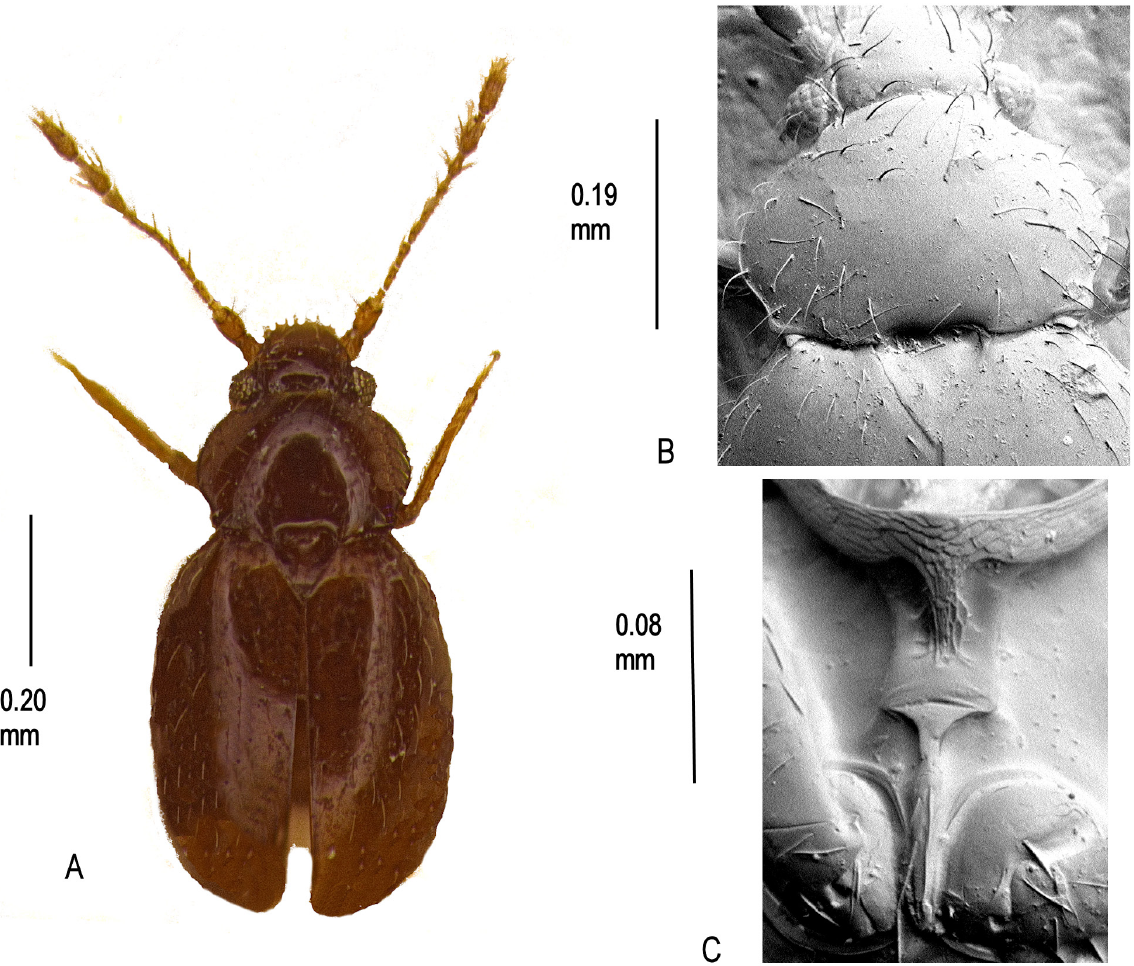
Fig. 75 . Cissidium luctuosum sp. nov. A . Habitus. B . Pronotum, × 605. C . Mesoventrite showing median process of collar, mid-keel and keel,